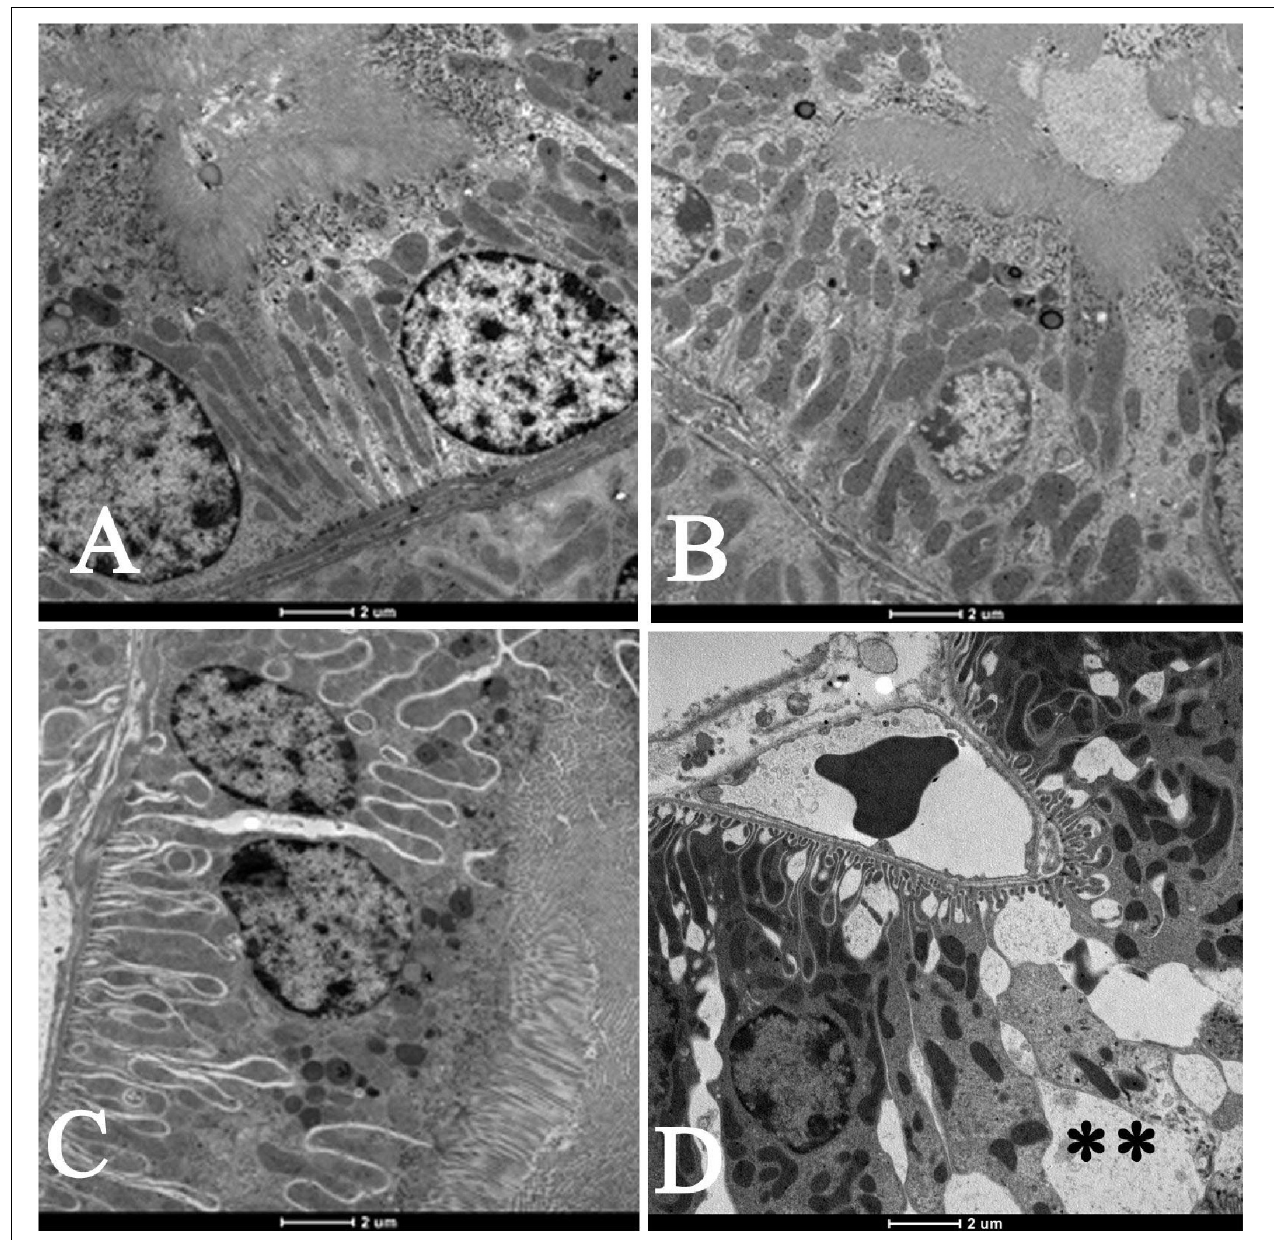
FIGURE 3 | Electron micrographs of the proximal convoluted tubules (PCT) of the kidney of mice at the end of 1-week exposure period to air (control, A ), 1-week exposure period water pipe smoke (WPS) exposure (B) , 4-week exposure period to air (control, C ) or 4-week exposure period to WPS (D) . Large vacuoles ( ∗∗ ) were observed in the wall of the PCT of the kidney of mice exposed to WPS at 4-week exposure period. Scale bar = 2 µ m; n =